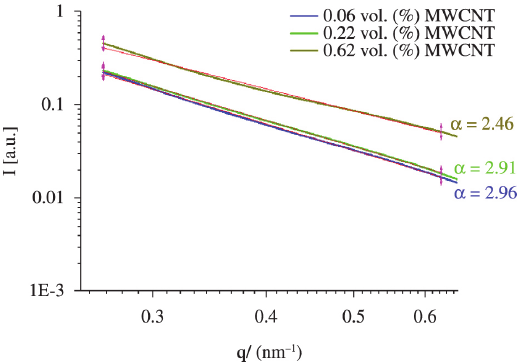
Figure 3. SAXS intensity as a function of the scattered q-vector plotted in double logarithmic scale for nanocomposites of MWCNT/